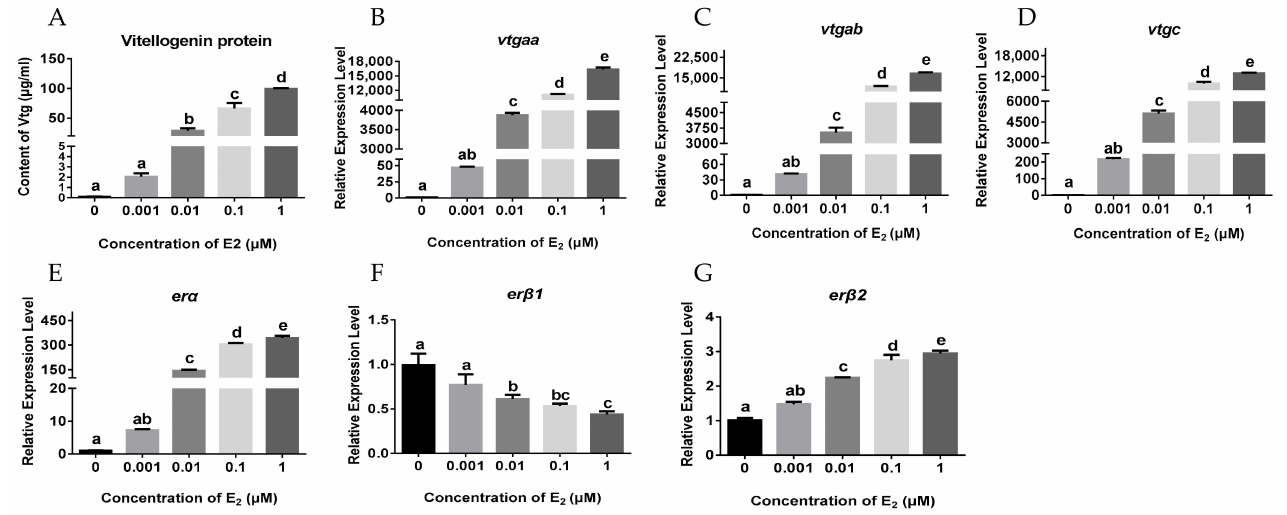
Figure 3. Effects of E 2 treatment on the expression of vtgs and ers in primary hepatocytes: ( A ) VTG protein levels in the hepatocytes; ( B – G ) the mRNA levels of vtgaa , vtgab , vtgc , er α , er β 1 and er β 2 in the hepatocytes. The cells were treated with different dose of E 2 for 24 h. Data are expressed as the mean ± SEM ( n = 4) and analyzed by one-way ANOVA followed by Tukey’s post-hoc test. Different letters above the error bars indicate statistical differences at p <